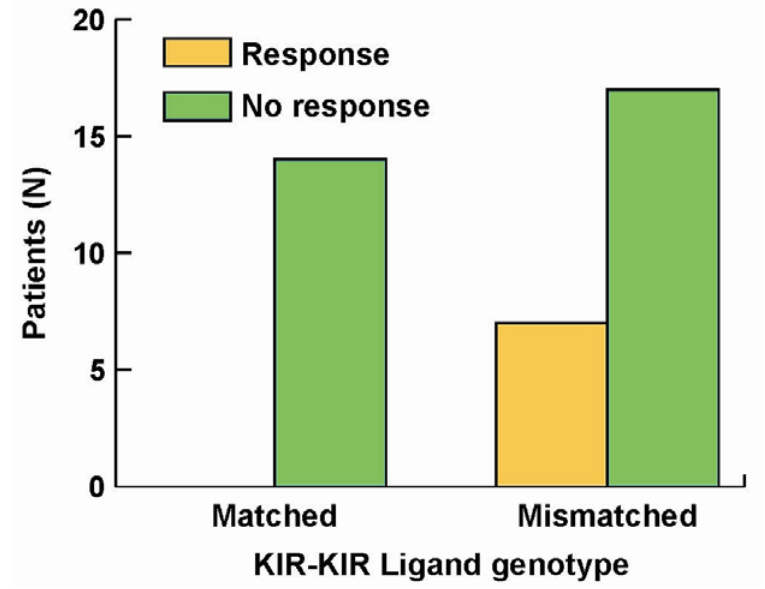
Figure 3. Importance of KIR/KIR-Ligand mismatch in clinical response to